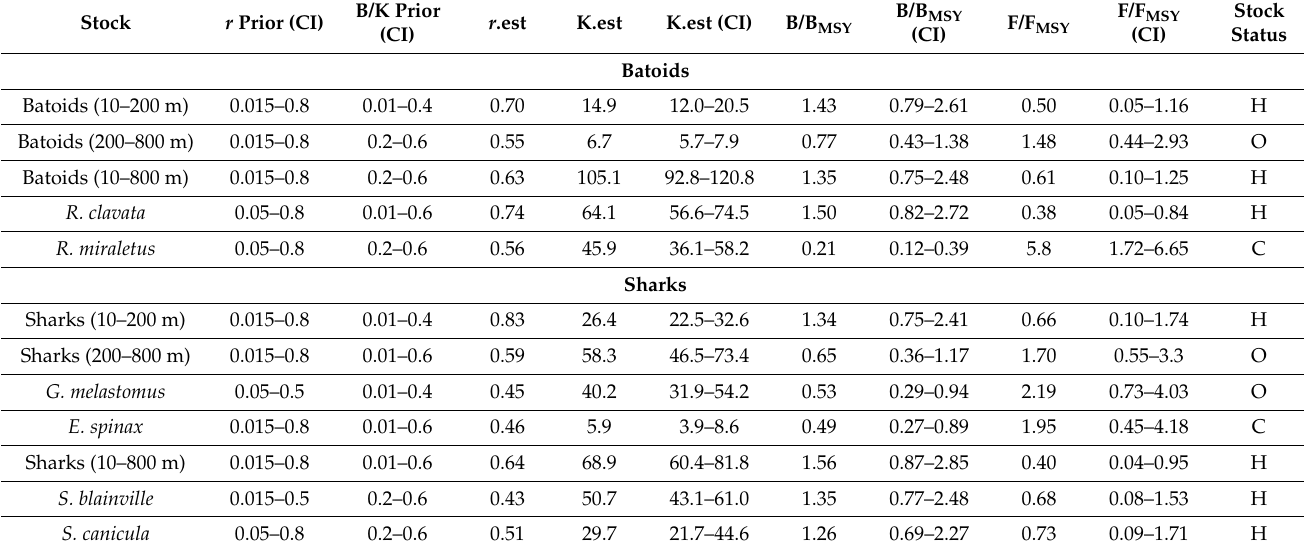
Table 1. Outputs and prior values used to fit the AMSY model. r. est, estimated resilience; K.est, estimated carrying capacity; CI, 95% confidence interval; H, healthy; O, overfished; C,